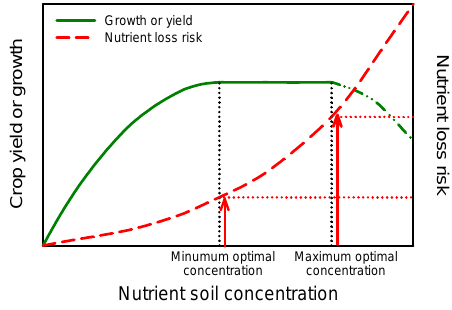
Figure 1. Relationship between crop growth (or yield) and nutrient soil concentration in the root zone. The maintaining of the minimum optimal nutrient concentration allows for reducing nutrient loss risk (e.g., NO 3 − leaching) without affecting crop produce and quality.